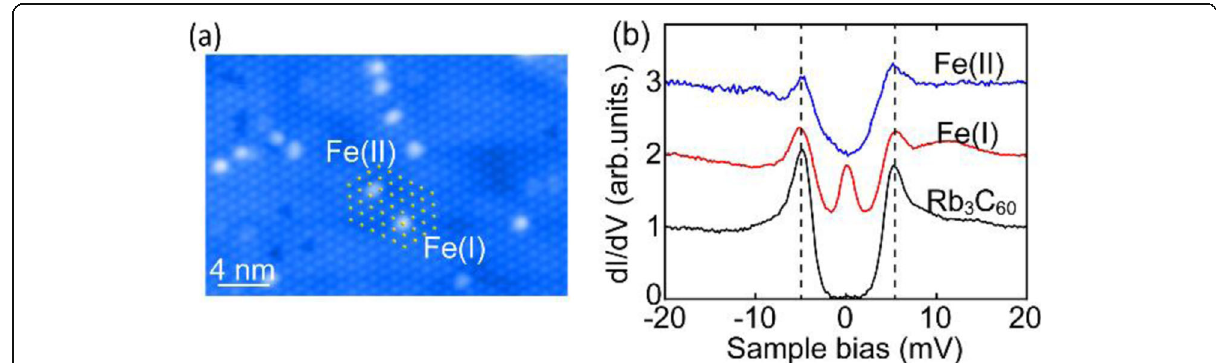
Fig. 12 Fe-induced bound states. ( a ) STM topography of Rb 3 C 60 films with diluted Fe adatoms. ( b ) Averaged d I /d V spectra on Fe-I, Fe-II impurities, and locations far from any impurities. Taken from ref.